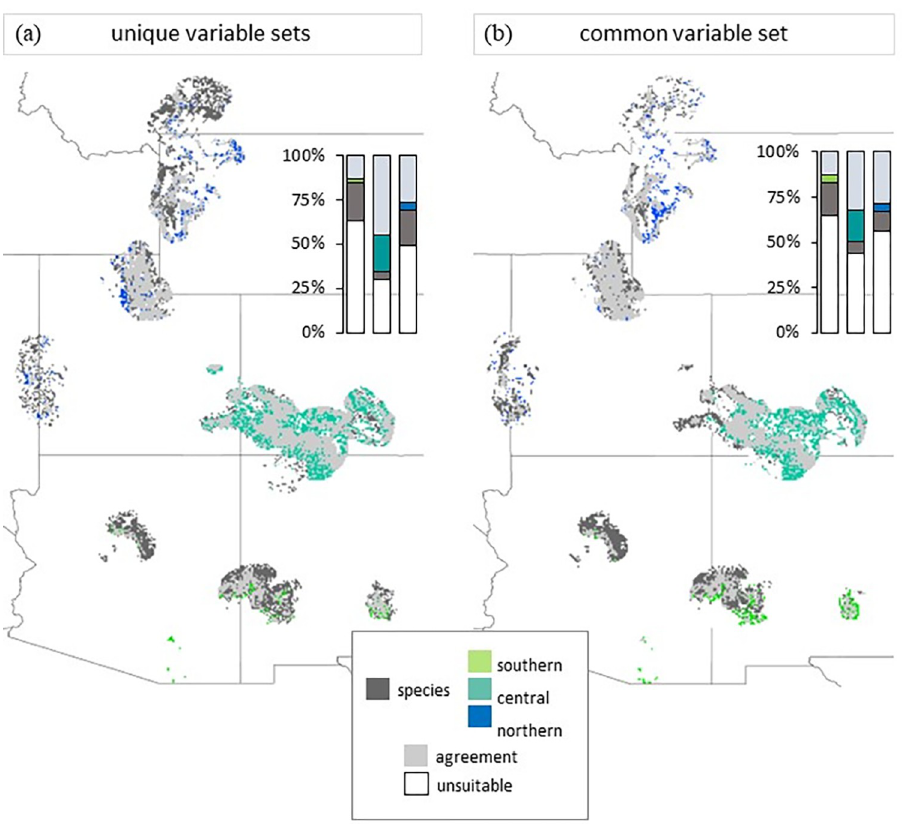
Fig 2. Geographic overlap of species predictions and population model predictions within the population geographic ranges. Panel (a) represents model comparisons built from “unique” variable sets and panel (b) represents model comparisons built from a “common” variable set. Inset stacked bar plots represent the percentage of the landscape within each population’s geographic range that was predicted as suitable habitat by the species model and each population model. Agreement between the model pairs on suitable habitat is represented in light grey on maps and bar plots. Though visualized together, calculations of overlap were calculated within each population extent: see S1 Fig in S1